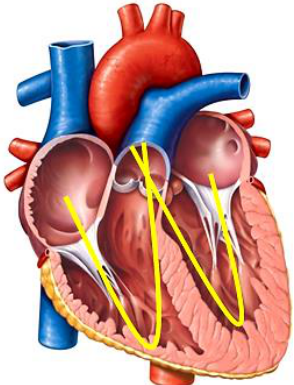
Figure 4. The “W” flows inside the heart (yellow lines).